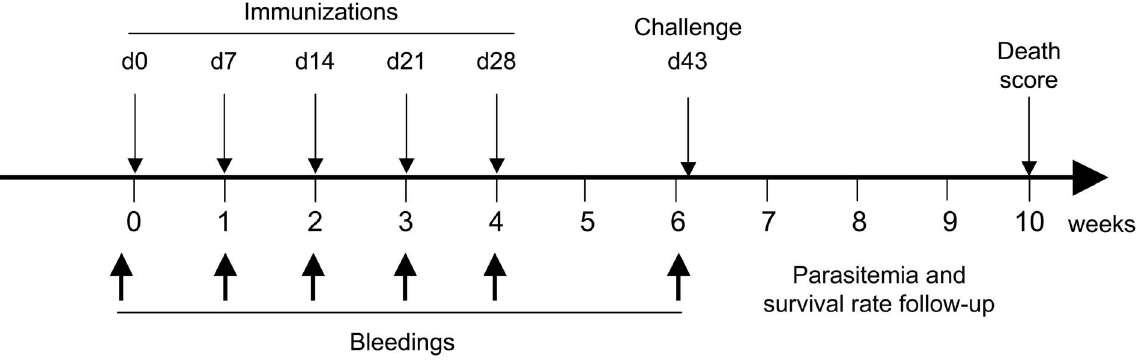
Figure 6. Schematic representation of the immunization protocol. Immunization and challenge schedule is given in days (d) and bleeding time points in weeks.